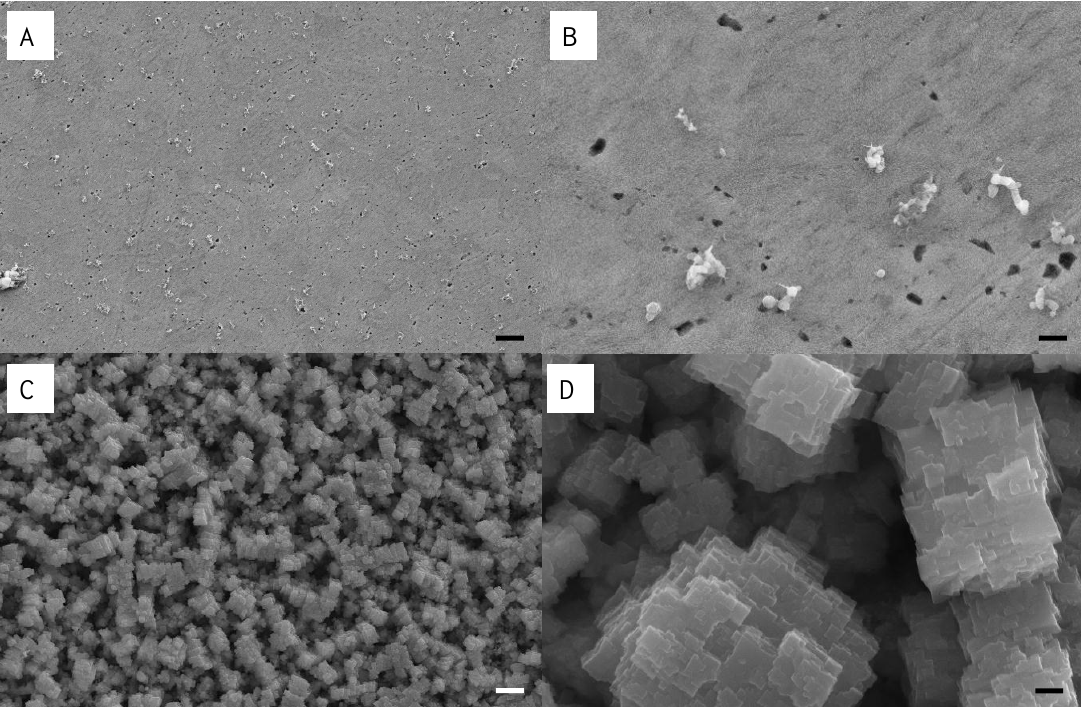
Figure 9. Representative SEMs of the surface of a 10 wt% Si-Cu composite before ( A , B ) and after ( C , D ) HF etching; scale bars of ( A , C ) and ( B , D ) respectively correspond to 2 μm and 200